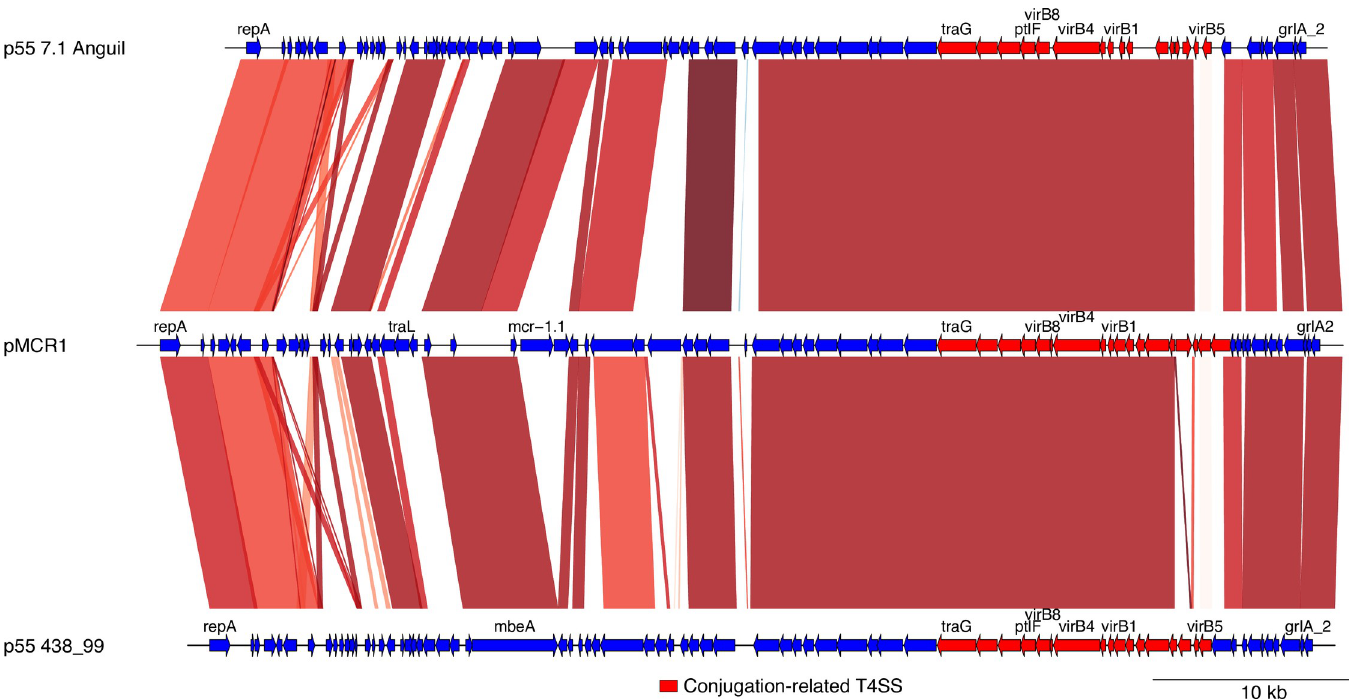
Fig 4. Alignment of the p55 plasmid of strains 7.1Anguil and 146N4 with a related pMCR1plasmid. Plasmid are represented in lineal forms with blue and red arrows indicating genes. Artemis comparison tool was used to indicate regions of similarity (red), inversions (blue) and In/dels (clear).